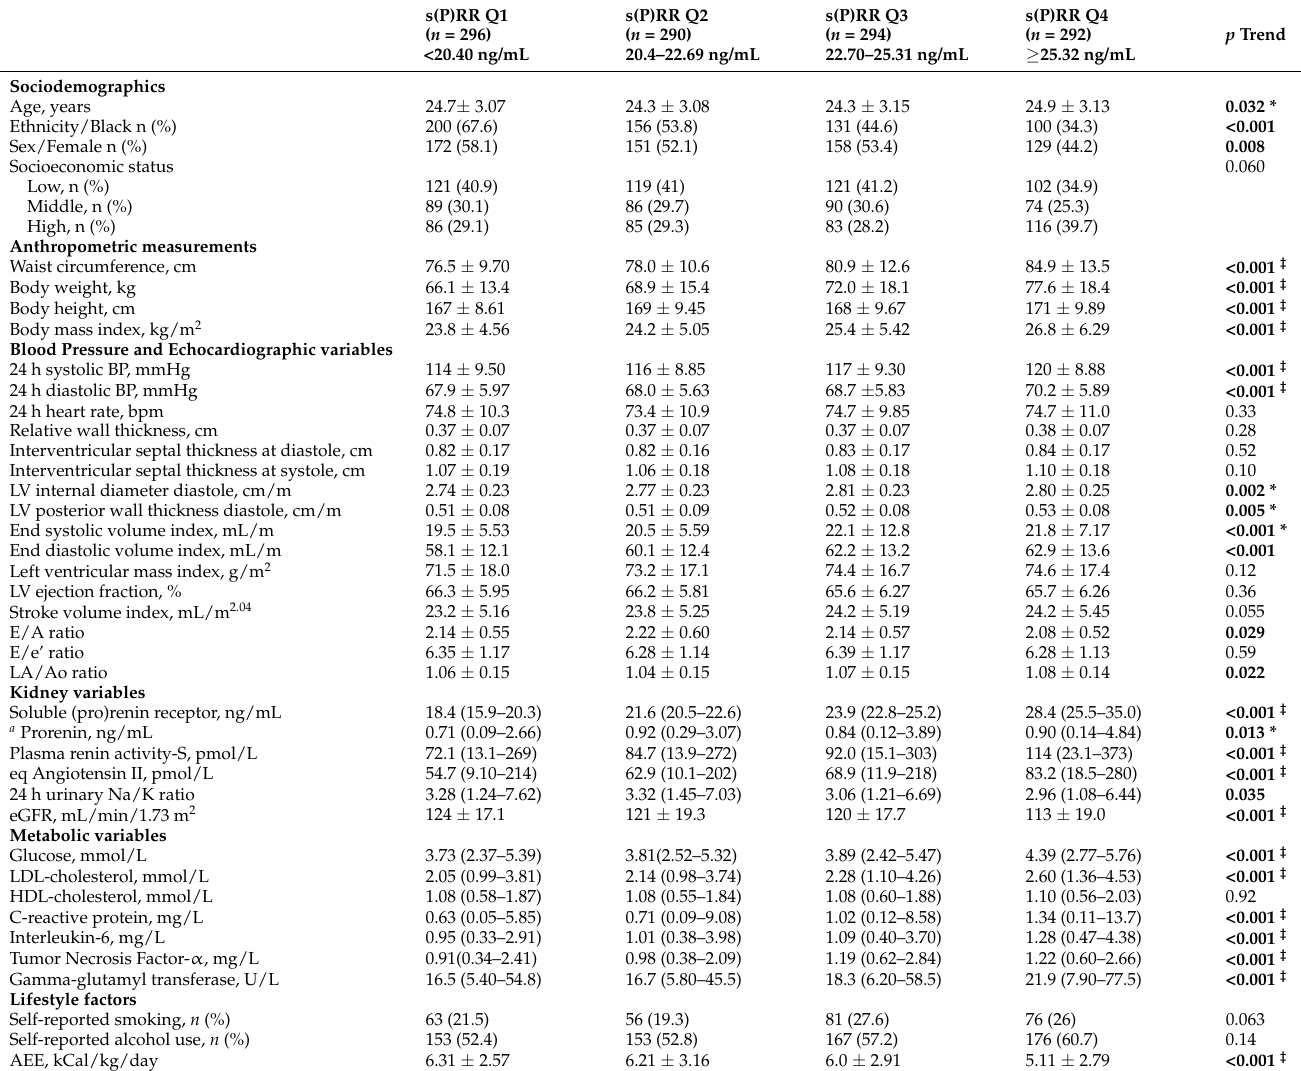
Table 1. Characteristics of the population across quartiles of soluble (pro)renin